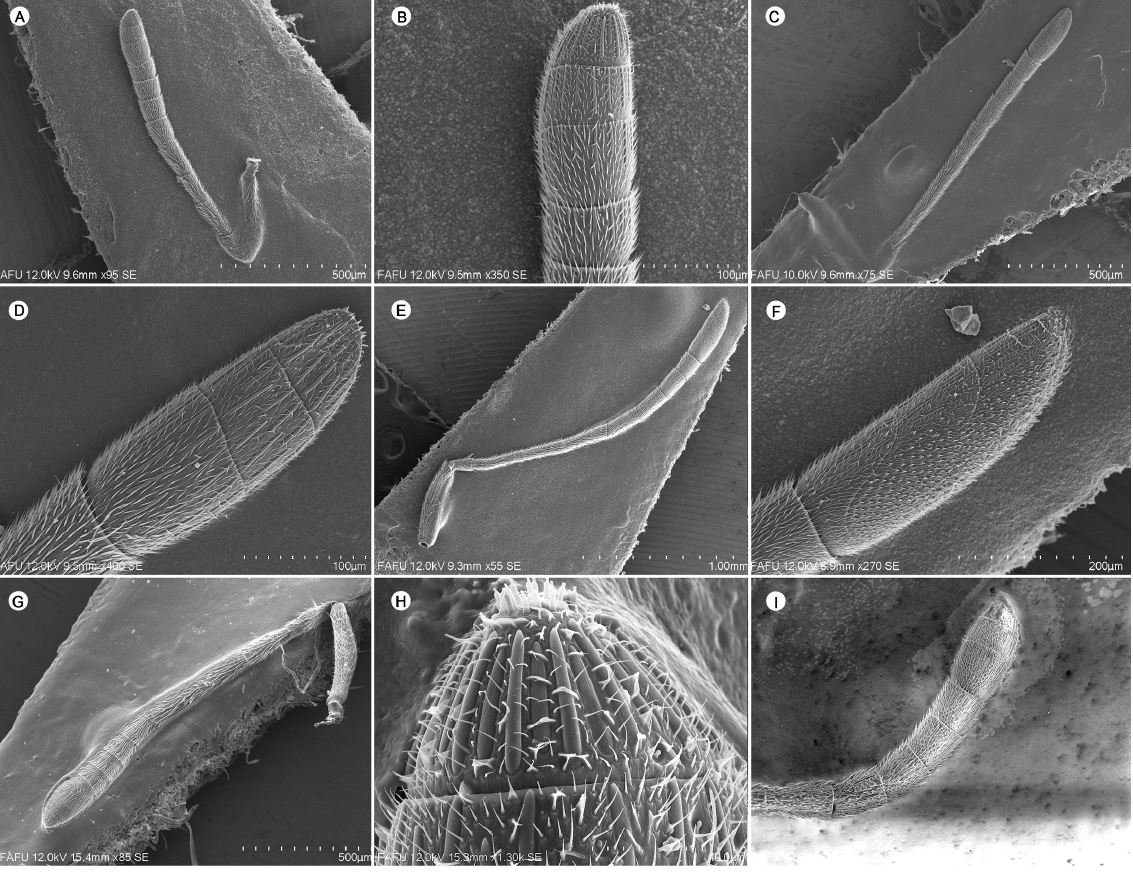
Fig. 9. SEM photos of antennae. A‒B . Zaischnopsis covid Jiang & Peng sp. nov. C‒D . Z. fuscolivida Tang & Peng sp. nov. E‒F . Z. lii Jiang & Peng sp. nov. G‒H . Z. campaniformis Tang & Peng sp. nov. I . Z. pacis Jiang & Peng sp.